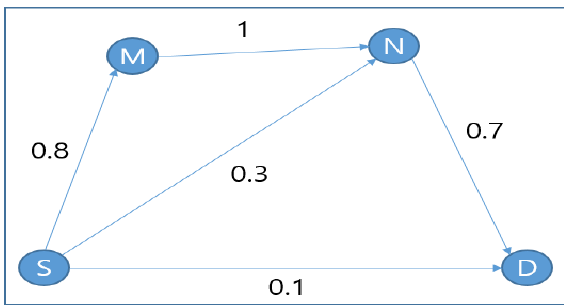
Figure 3. A network with the link delivery probability of each node pair [4].